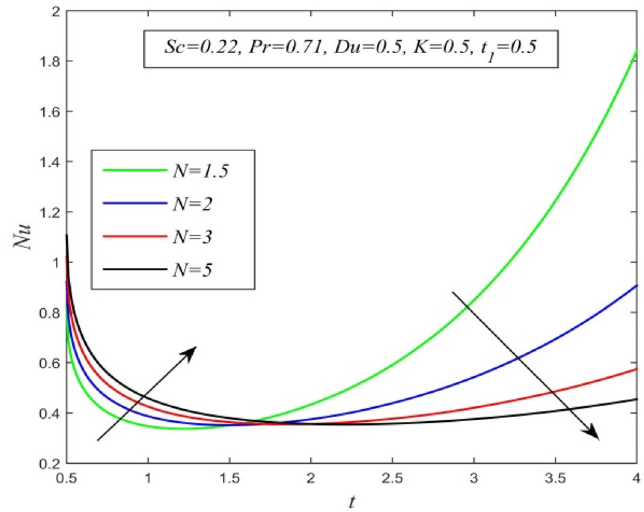
Figure 23. Nu versus t for different N and Sc = 0.22, Pr = 0.71, Du = 0.5, K = 0.5, t 1 = 0.5.